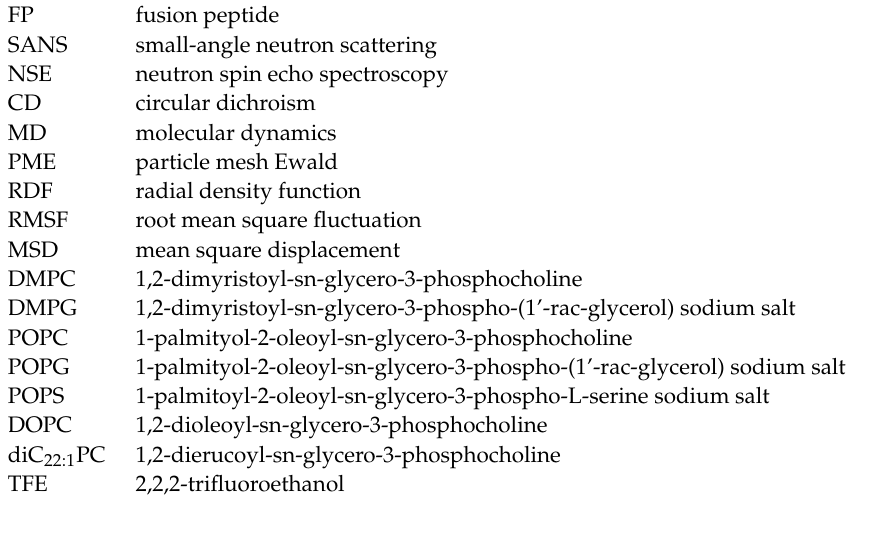
Figure S2: Schematic of the volumetric model of the lipid bilayer; Figure S3: χ 2 vs. f insert plots; Figure S4: NSE data collected for the vesicles; RMSF values calculated from the simulations; Figure S6: MSDs calculated from the simulations; Figure S7: Lipid chain order parameters calculated from the simulations; Figure S8: Histograms of the minimum distances between the gp41rk amino acids and the lipids in the Lipid-3/gp41rk simulation; Figure S9: Histograms of the minimum distances between the gp41rk amino acids and the four types of lipids in the Lipid-3/gp41rk simulation; Table S1: Parameters for SANS data analysis; Table S2: Results of SANS data